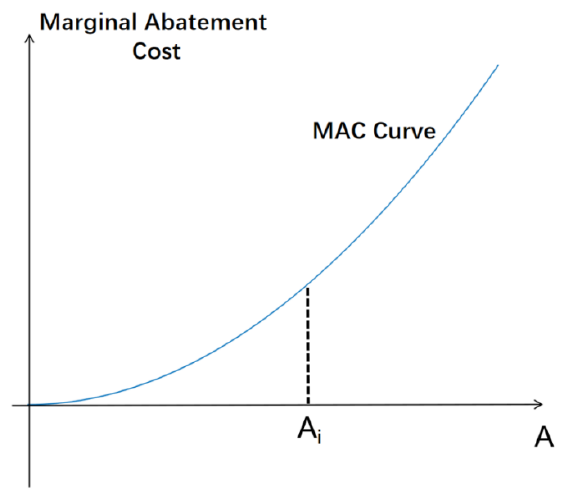
Figure 4. MAC curve fitting